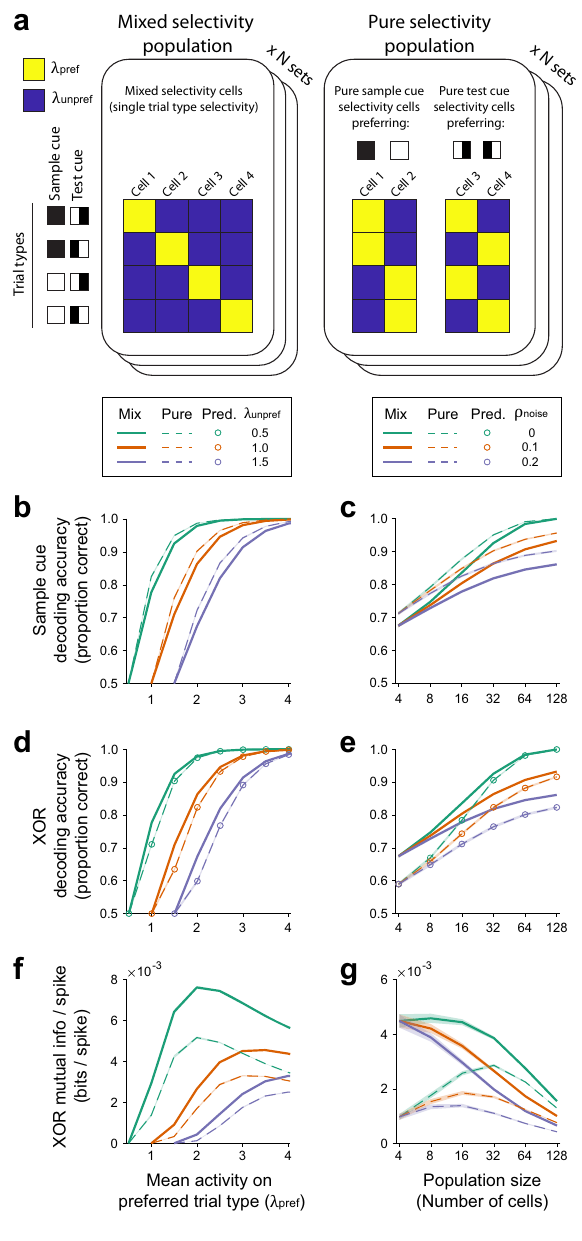
Fig. 7 | Decoding accuracy from simulated mixed and pure selectivity popu- lations. a Schematic of simulated population. The number of spikes generated by each cell follows a Poisson distribution with the mean λ . Each cell responds to a preferredcue(orapreferredcombinationofcues)withthemeanof λ pref andtoan unpreferredcuewiththemeanof λ unpref .Theminimumunitpopulationsizeisaset offourcells(roundedrectangle).Eachcellpreferentiallyrespondstoaspeci fi ctrial type in the mixed selectivity population, or to a speci fi c sample cue or test cue identity in the pure selectivity population. The population size increases by including N sets of the unit population with the same selectivity pattern. b Decoding accuracy for the sample cue (or test cue) in simulated population activityunderavariouscombinationofthemeanactivity( λ pref and λ unpref ).TheSNR in the population increases with higher λ pref and lower λ unpref under Poisson noise. Thepopulationactivitywas simulated on10,000trialsandrepeated 10,000times, separately in mixed selectivity population (solid lines) and pure selectivity popu- lation (dashed lines). Shading indicates mean ± s.e.m. and is equal or smaller than the line widths. The population activity was simulated with 8 cells and noise cor- ρ noise Pred. relation ( ρ noise =0.1) in panels ( b , d , f ). c Similar to panel ( b ), but under various combinations of the population size and noise correlation level. The SNR in the populationincreaseswithalargerpopulationsizeandlowernoisecorrelation.The populationactivitywas simulated with λ pref =2.0and λ unpref =1.0inpanels( c , e , g ). d Similar to panel ( b ), but with the decoding accuracy for the reward direction (XOR). For a pure selectivity population, the decoding accuracy of XOR ( p XOR , dashed line in panels d , e ) can be predicted by decoding accuracy for the sample cue(ortestcue)( p ,dashedlineinpanels b , c ).Opencirclesshow ^ p XOR predictedby p 2 +(1 – p ) 2 : the sum of probabilities that both sample and test cues decoded cor- rectly ( p 2 ) or incorrectly (1 – p ) 2 . See Supplementary Fig. 10 for reasoning. e Similar to panel ( c ), but with the decoding accuracy for the reward direction (XOR). f Similartopanel( d ),butwithXORmutualinformationdividedbythetotalnumber of expected spikes in a population. g Similar to panel ( e ), but with XOR mutual informationdividedbythetotalnumberofexpectedspikesinapopulation.Source data are provided as a Source Data fi